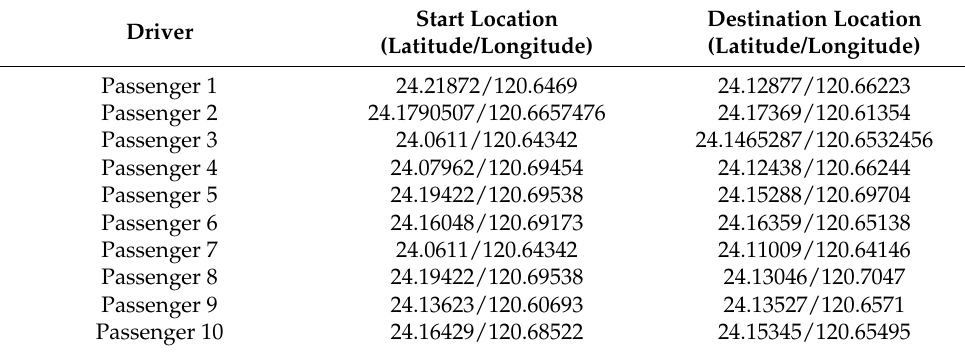
Table 5. Start locations and end locations of passengers.